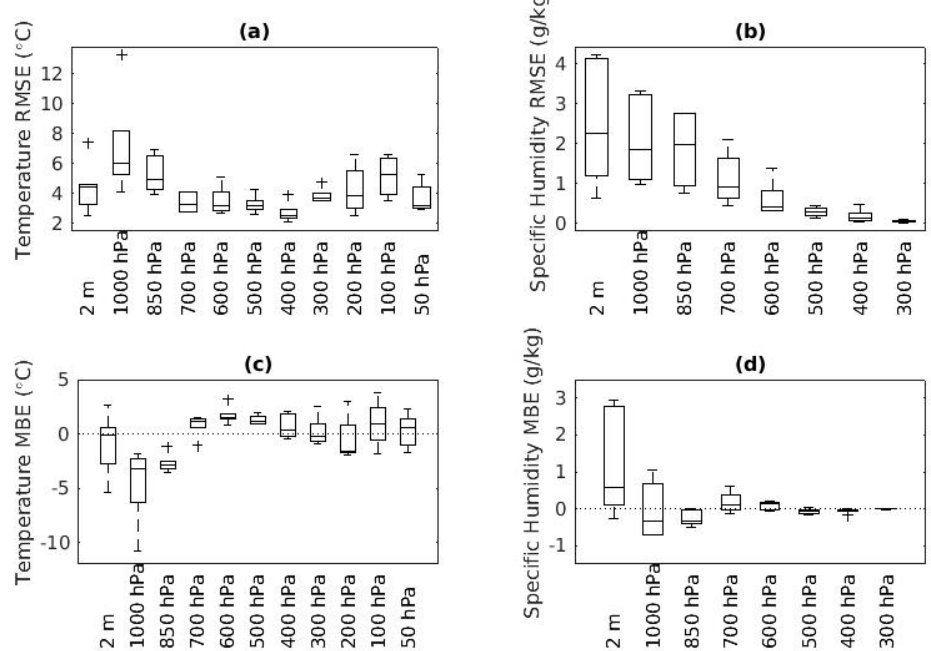
Figure 5. Boxplots of comparisons between HIRS and reference upper-air network (GRUAN) stations for temperature and specific humidity, root mean square error (RMSE) and MBEs. Along the horizontal axis delineates the profile height from 2 m to 50 hPa. The central mark in each box indicates the median value amongst all GRUAN stations. The edges of the box are the 25th (Q1) and 75th (Q3) percentiles, while the whiskers extend to values within Q3+W*(Q3-Q1) and Q1-W*(Q3-Q1) (roughly 99.3 coverage of normally distributed values) where W = 1.5. The plus signs indicate outlier values. ( a ) Temperature RMSE ( ◦ C); ( b ) specific humidity RMSE (g/kg); ( c ) temperature MBE ( ◦ C); ( d ) specific humidity MBE (g/kg).